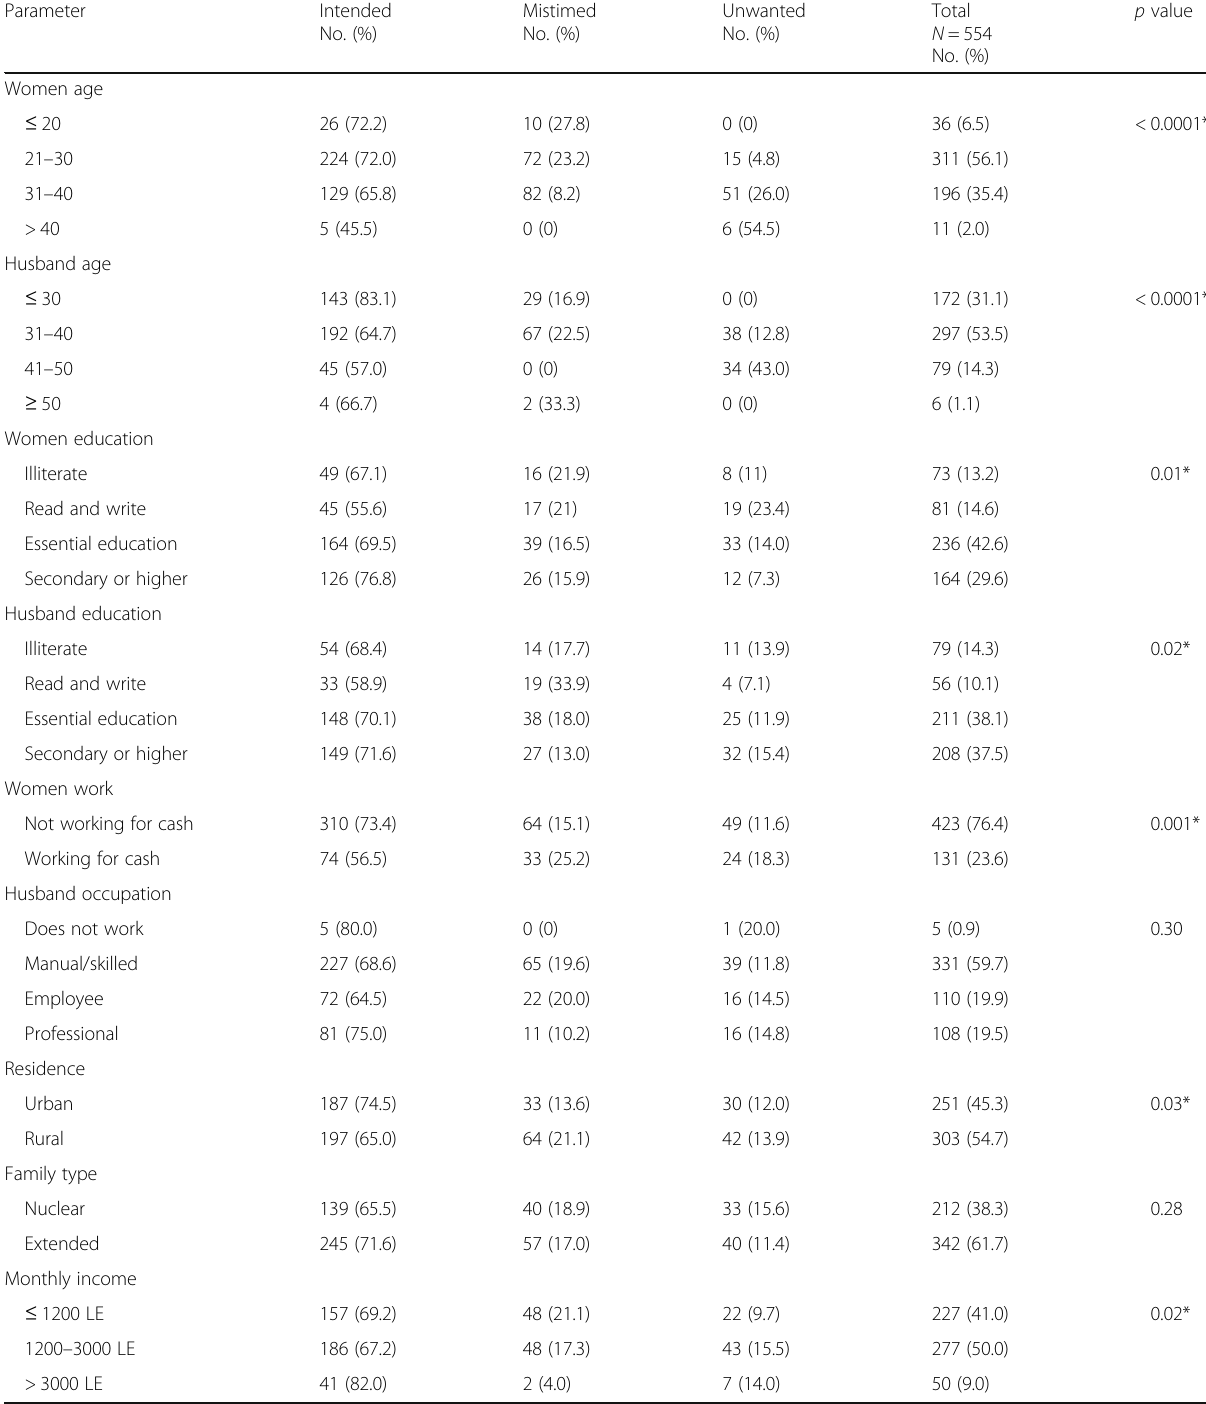
Table 1 Pregnancy intention status in relation to women ’ s sociodemographic factors, Sohag district, Egypt, 2016 Parameter Intended Mistimed No. (%) No.